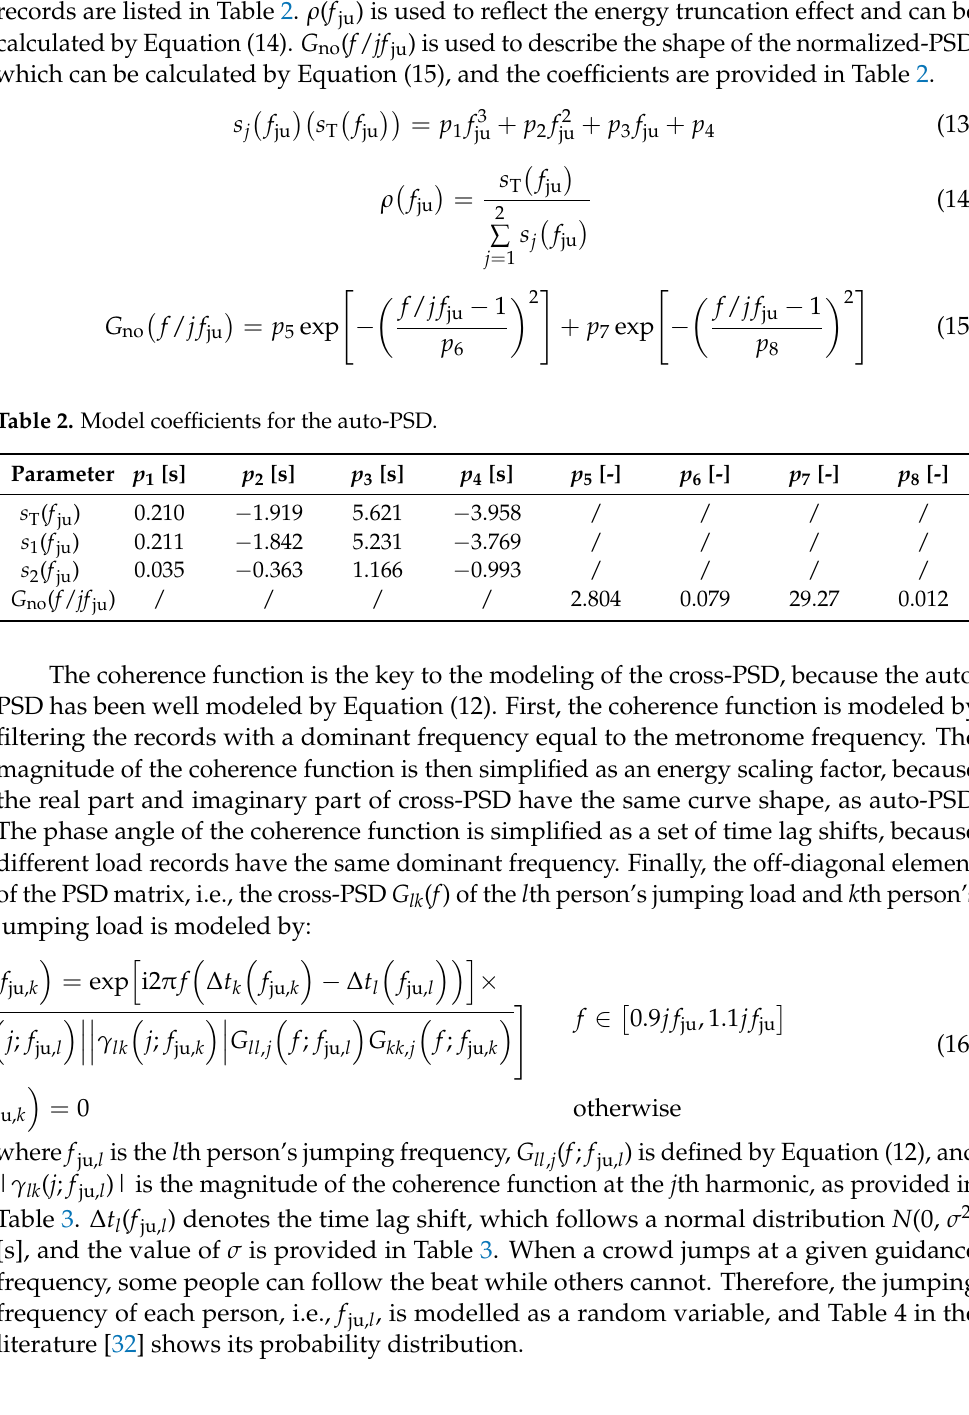
literature [32] shows its probability